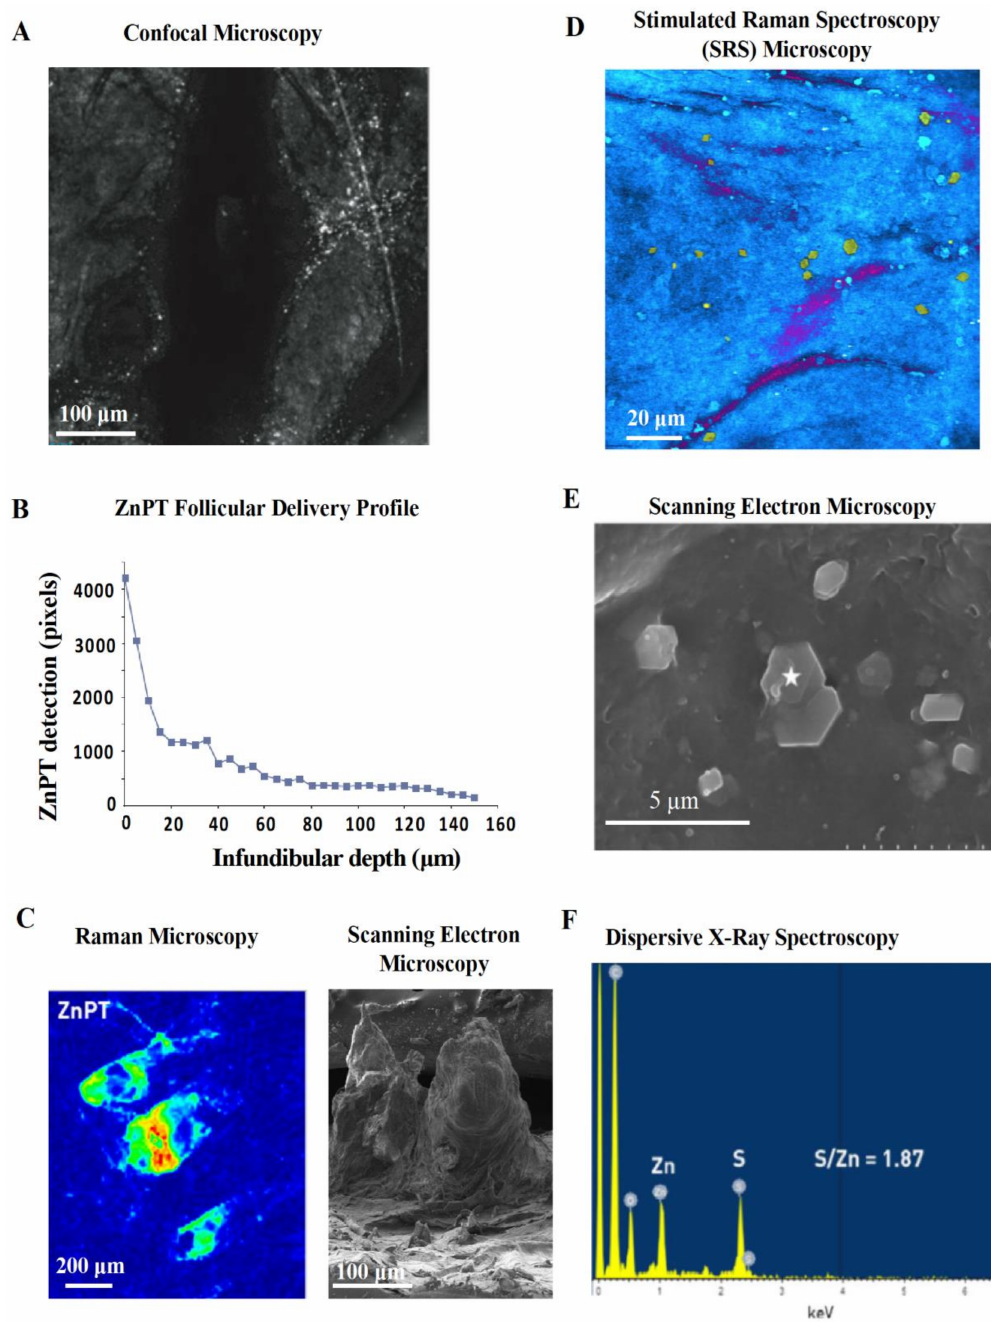
Figure 7. Reflectance and scattering methods for assessing zinc pyrithione topical delivery. ( A ) In vivo reflectance confocal image (40 µ m) of human hair follicle showing particle deposition and ( B ) accompanying pixel-depth profile. Schwartz et al. (2011), reproduced with permission [115]. ( C ) Raman microscopy image, intensity weighted by color (red—high, blue—low), of an ex vivo cyano-acrylate hair follicle biopsy with accompanying scanning electron microscopy (SEM) image of cyano-acrylate follicular cast. Chen et al. (2017), reproduced with permission [128]. ( D ) Stimulated Raman Spectroscopy (SRS) microscopy image of ZnPT (yellow particles) and climbazole (magenta) on the surface of ex vivo porcine skin. Garrett et al. (2017), reproduced with permission [129]. ( E ) SEM image of tape stripped skin from scalp washed with ZnPT shampoo with ( F ) accompanying dispersive X-ray spectra (from the star marked region) confirming its chemical identity. Chen et al. (2018), reproduced with permission